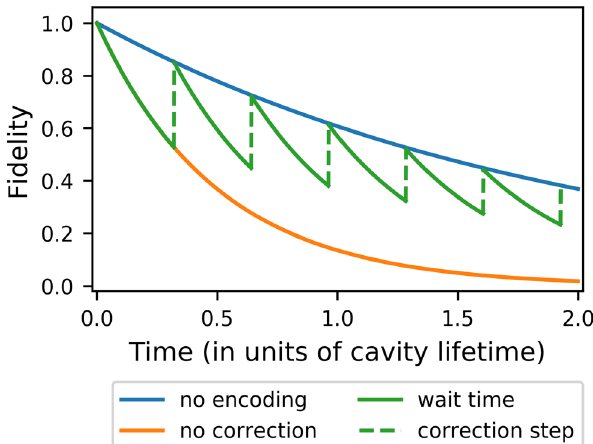
Fig. 5 Logical qubit lifetime at the “ break even ” regime where it begins to outperform unprotected qubits. In blue, we see the decay of a single photon, i.e., an unprotected single-rail qubit. In orange, we see the decay of our two-mode code if we do not perform any correction operations — it decays faster as it contains a higher number of photons. The green line represents the decay of the encoded qubit in the presence of periodic correction operations. The in fi delity of the correction operations due to photon loss that can happen during the operation is taken into account. The fi gure represents a lower bound for the performance of our protocol, with bene fi cial higher order effects being neglected in order to simplify the simulation. The “ break even ” point is achieved at V shg (cid:1) 10 (cid:3) 3 λ 3 n , Q ~ 2 × 10 8 , 3 and χ ð 2 Þ (cid:1) 100 pm for λ a ~ 750 nm. Waveguide losses are neglected, as they V would be insigni fi cant compared to the rest of the